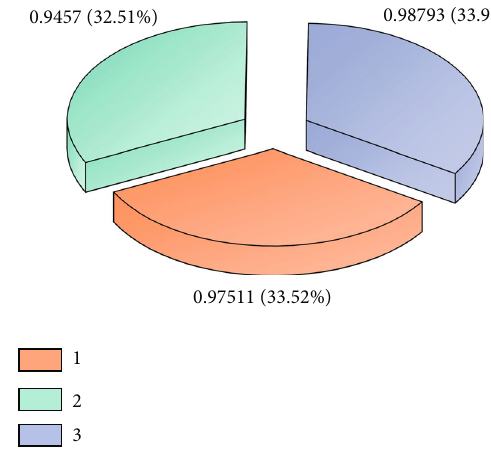
Figure 12: Schemes 1 – 3. Impact of group safety psychology on behavior